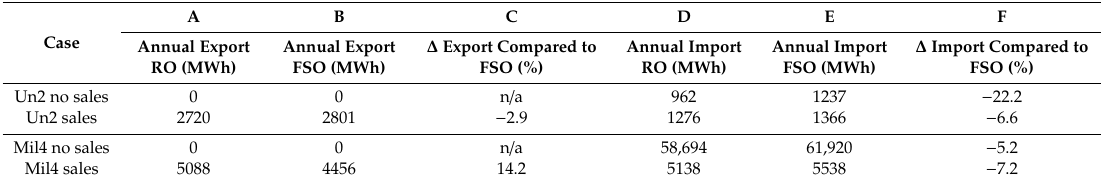
Table 4. Import and export balance for the energy sale sensitivity runs as well as the original runs without